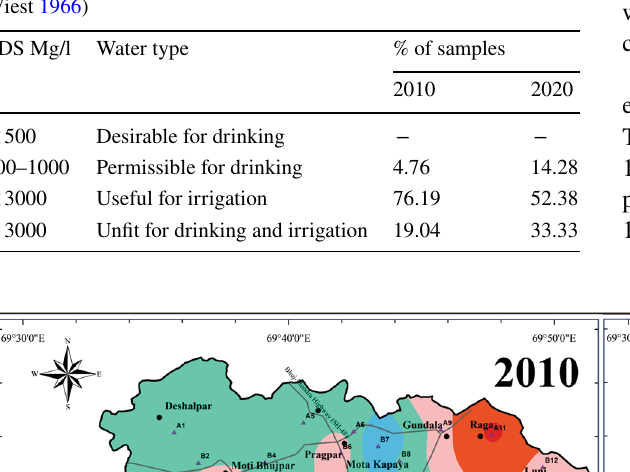
Table 2 Classification of groundwater based on TDS (Davis and De